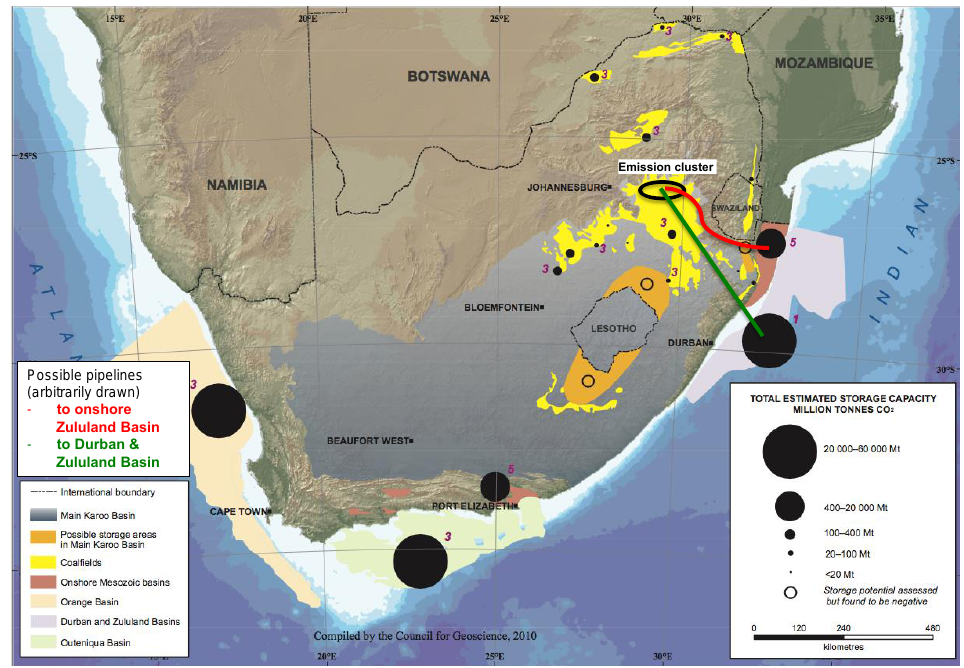
Figure 3. Sedimentary basins in South Africa, potential storage capacity and possible pipelines between CO 2 sources and storage sites (modified from [29]).